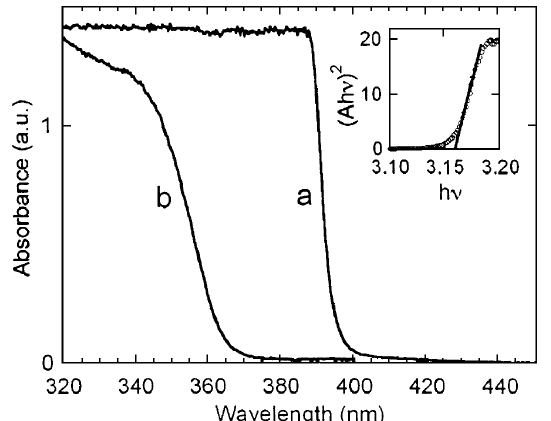
Fig. 6 Distribution results of ZnO QDs after 2 h of growth at 65 °C. The histogram was obtained from analysis of high-resolution transmission electron microscope im- ages of 125 particles. The solid line was obtained from the absorbance spectrum. Reprinted with permission from Pesika et al., “Relationship between Absorbance Spectra and Particle Size Distributions for Quantum- Sized Nanocrystals” J. Phys. Chem. B 2003 107(38), p. 10412–10415. Copyright 2003 American